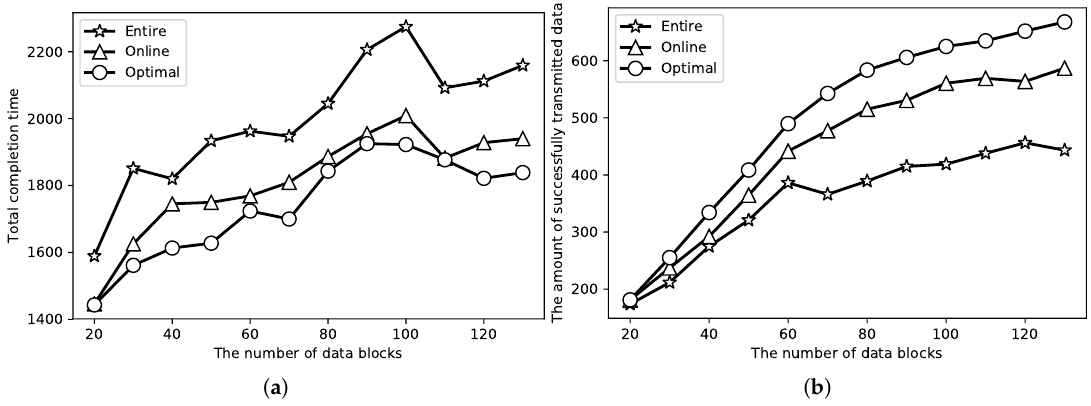
Figure 11. Result with real energy receiving process. ( a ) simulation for total completion time; ( b ) simulation for maximum successfully transmitted data